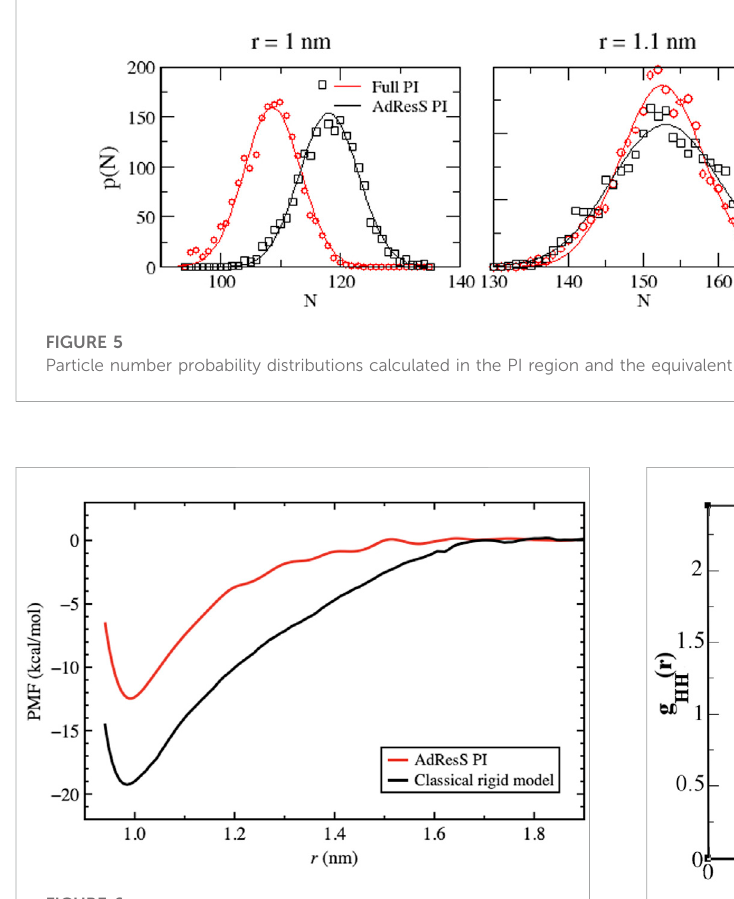
FIGURE 6 PMF for the path integral model using AdResS compared to the reference full atomistic classical simulation. The PMF is calculated as a function of the distance between the centers of mass of the C 60 molecules. The zero of each curve was chosen to be the corresponding bulk solvation energy, that is, the value of the PMF at the plateau.